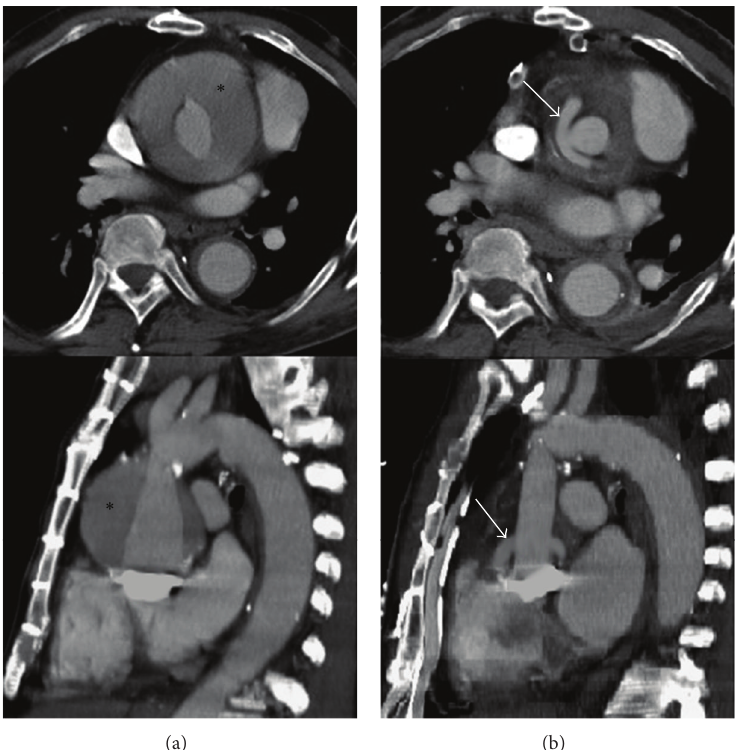
Figure 1: ((a): top and bottom) Preoperative contrast enhanced CT scan showing the ascending aortic prosthesis, the mechanical aortic valve, and the surrounding hemorrhage within the former aneurysmal sac (black asterisk). ((b): top and bottom) Postoperative contrast enhanced CT scan showing the Cabrol interposition graft (white